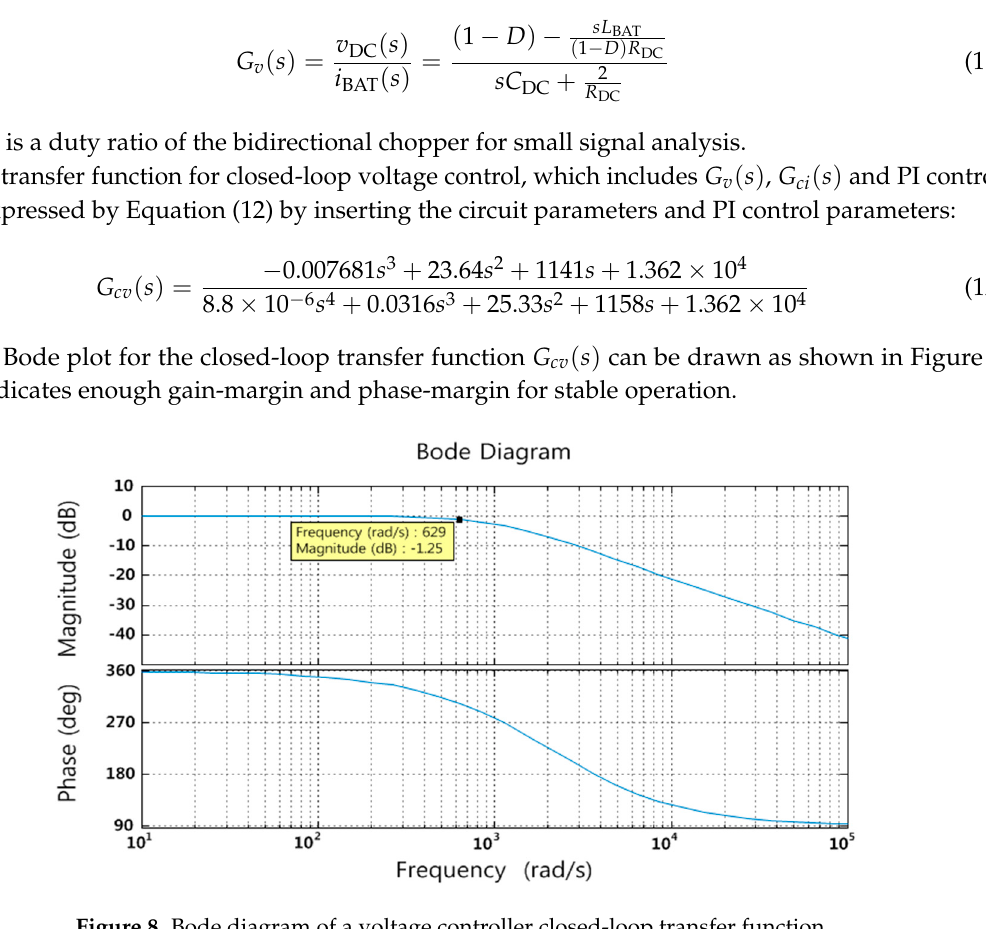
7 of 16 Figure 7. Bode diagram of current controller closed-loop transfer function.